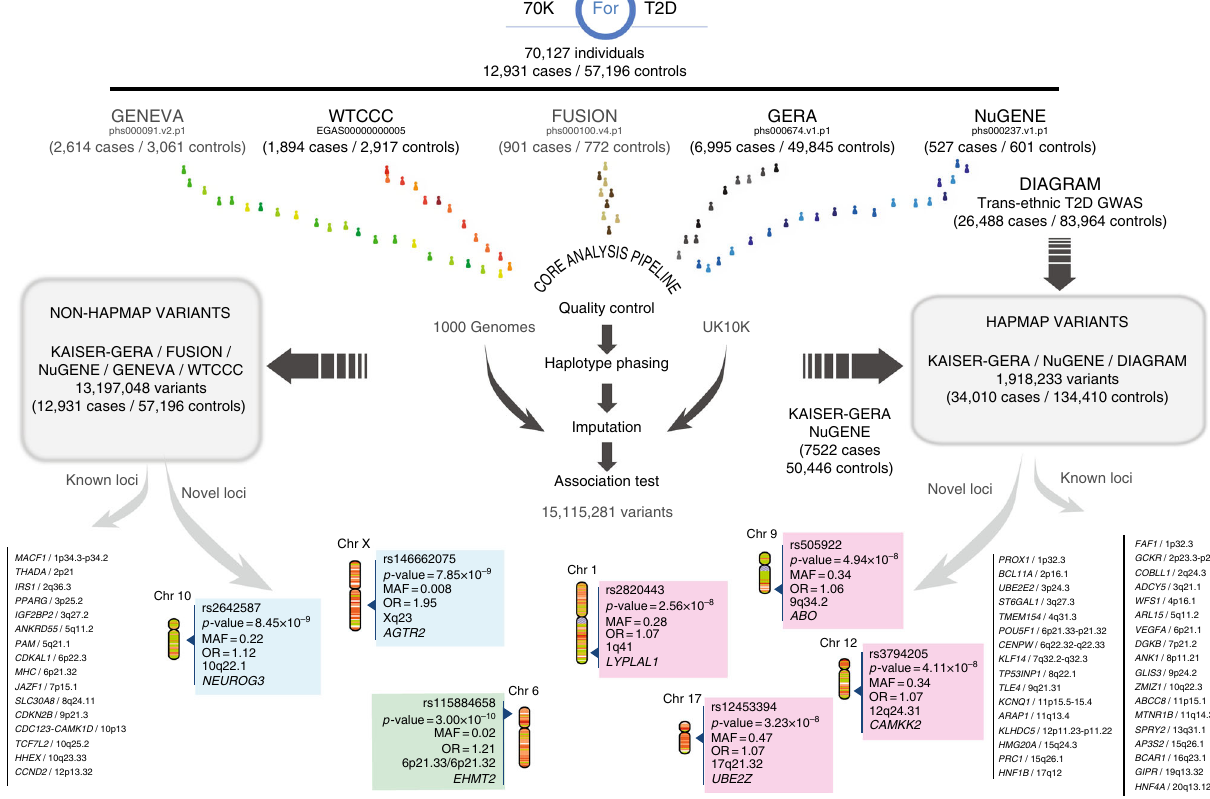
Fig. 1 Discovery and replication strategy. Publicly available GWAS datasets representing a total of 12,931 cases and 57,196 controls (70KforT2D) were fi rst quality controlled, phased, and imputed, using 1000G and UK10K separately. For those variants that were present in the DIAGRAM trans-ethnic meta- analysis, we used the summary statistics to meta-analyze our results with the cohorts that had no overlap with any of the cohorts included in the DIAGRAM trans-ethnic meta-analysis. With this fi rst meta-analysis, we discovered four novel loci (within magenta panels). For the rest of the variants, we meta-analyzed all the 70KforT2D data sets, which resulted in two novel loci (in blue panels). All the variants that were coding and showed a p -value of ≤ 1 × 10 − 4 were tested for replication by interrogating the summary statistics in the Type 2 Diabetes Knowledge Portal (T2D Portal) (http://www.type2diabetesgenetics.org/). This uncovered a novel low-frequency variant in the EHMT2 gene (highlighted with a green